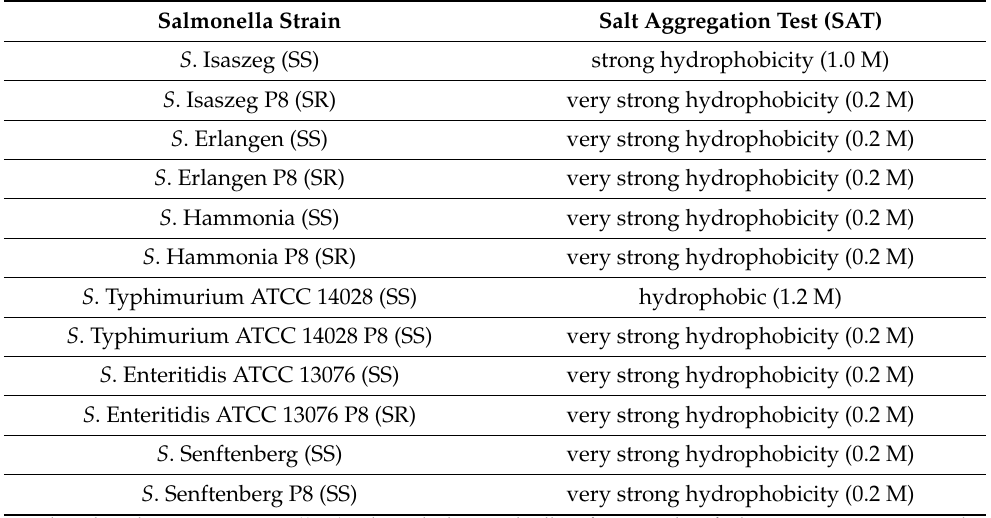
Table 5. Changes of cells’ hydrophobicity after passages in 50%